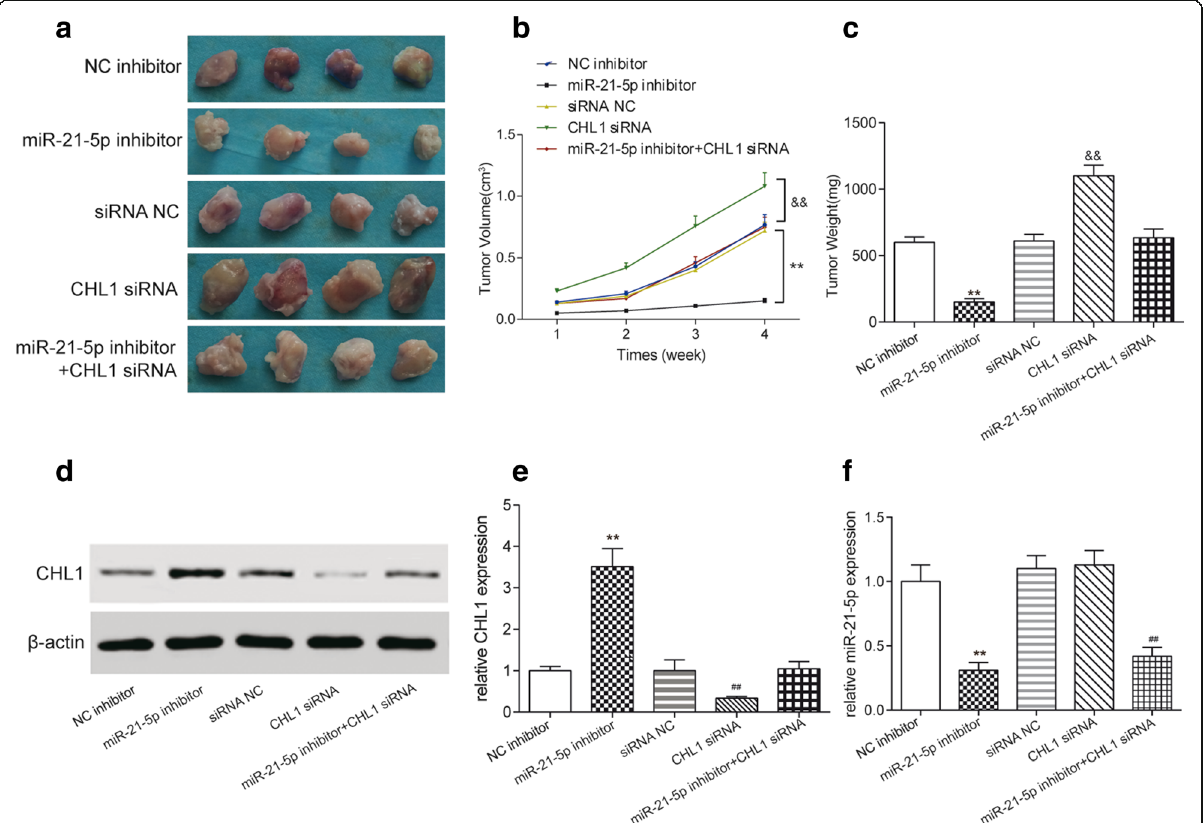
Fig. 8 MiR-21-5p promoted COAD tumor growth in vivo through inhibiting CHL1 expression. a - c The volume and weight of tumors in miR-21-5p inhibitor group were much lower than that in NC inhibitor group, while that in CHL1 siRNA group was higher than that in siRNA NC group. ** P <0.01, compared with NC inhibitor group, && P <0.01, compared with siRNA NC group. d , e CHL1 expression in miR-21-5p inhibitor group was much higher than that in NC inhibitor group, while that in CHL1 siRNA group was lower than that in siRNA group. Meanwhile, there was no significant difference between NC inhibitor group, siRNA NC group and miR-21-5p inhibitor+ CHL1 siRNA co-combination group. ** P <0.01, compared with NC inhibitor group, ## P <0.01, compared with siRNA NC group. f The expression of miR-21-5p was down-regulated by miR-21-5p inhibitor in vivo evaluated by qRT-PCR. ** P <0.01, compared with NC inhibitor group, ## P <0.01, compared with siRNA NC